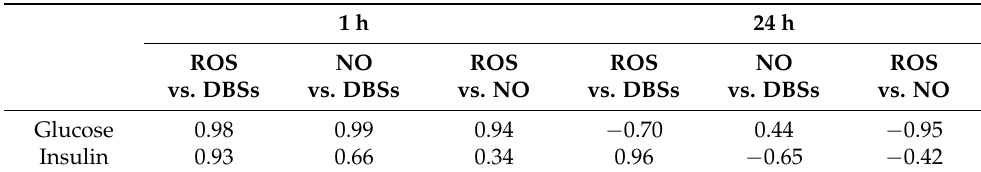
Table 1. Correlations between measured parameters ROS, NO and DBSs in neuron-like cells after glucose or insulin treatment for 1 and 24 h.